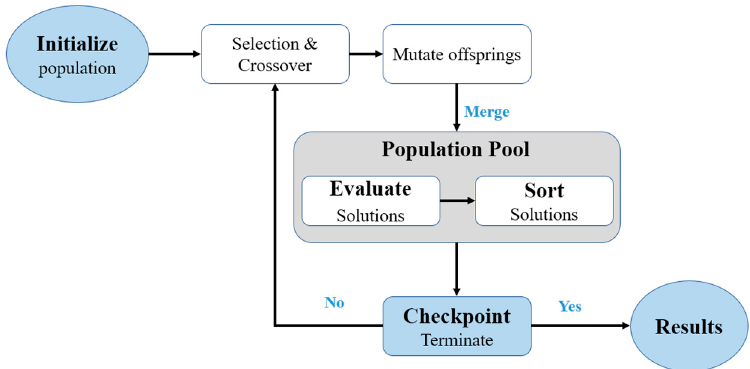
Figure 4. Genetic algorithm